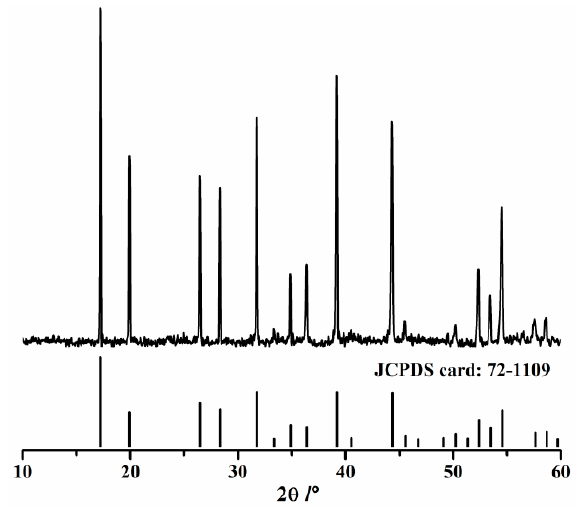
Figure 3. XRD spectrum of hydrated products of C 12 A 7 .